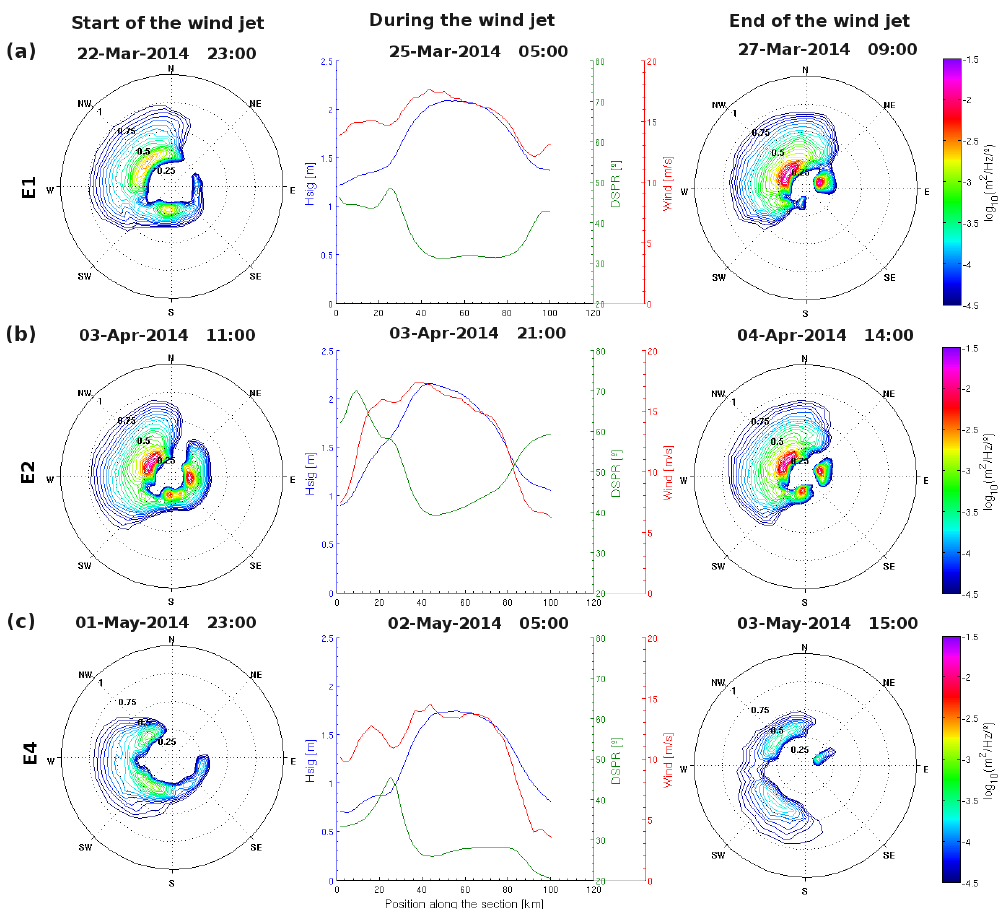
Figure 9. Wind jet responses for the remaining events. The spectrum at P2 at the start and the end of the wind jet is presented, as well as a section of the behavior during the wind jet. ( a ) Event E1. ( b ) Event E2. ( c ) Event